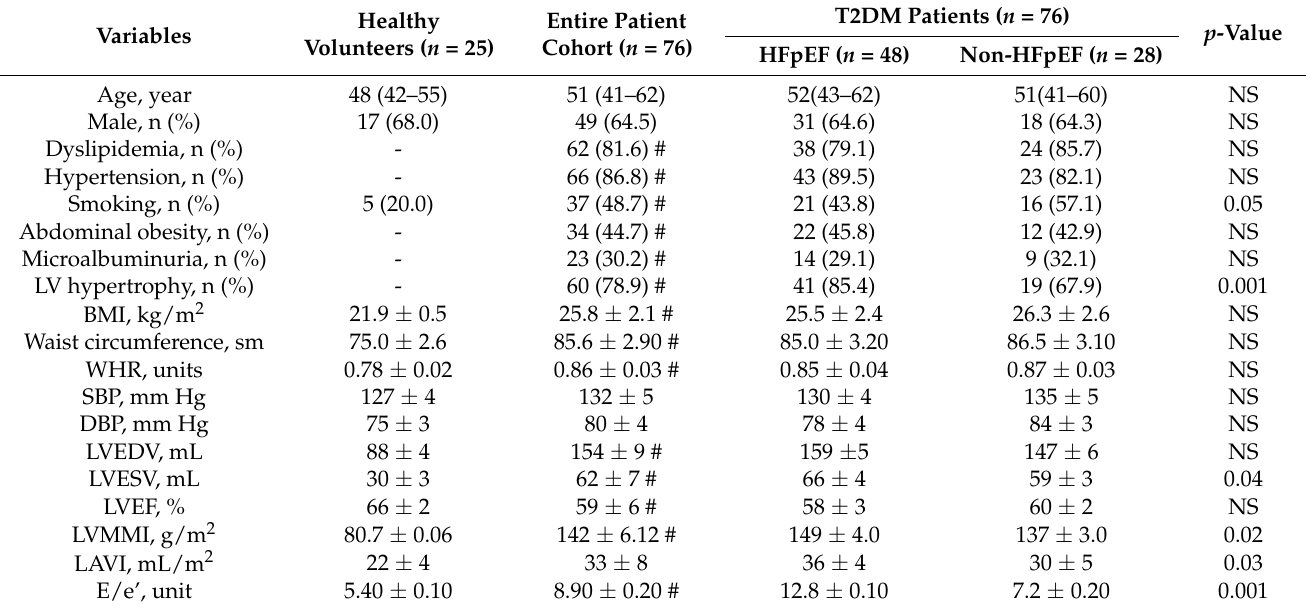
Table 1. Basic demographic, clinical and hemodynamic characteristics of patients’ study